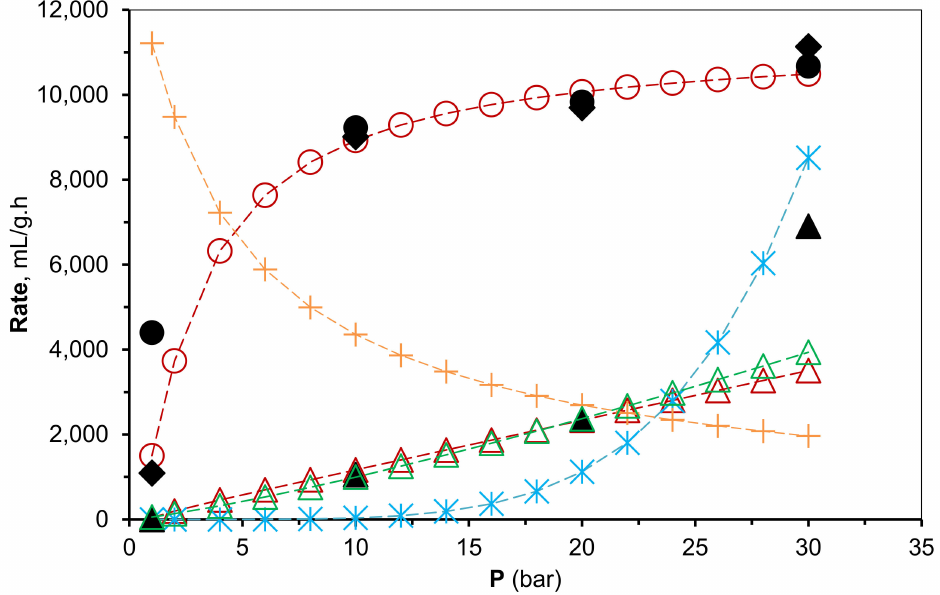
Figure 12. Correlation between experimental reaction rates obtained at 300 ◦ C and 30 bar over nickel– and cobalt–cerium bimetallic oxides prepared by the Pechini method (filled black circle and filled black triangle, respectively) and simulated data ( Langmuir–Hinshelwood–Hougen–Watson model power law: red circle, Equation (3); Chiang and Hopper power laws: red triangle, Equation (4) and orange cross, Equation (5); linear power laws, blue asterisk, Equation (2) x = 4, y = 1 and green triangle, Equation (2), x = 0.25, y = 1). Filled black lozenges correspond to the experimental data obtained over the reference catalyst (5 wt.% Rh/Al 2 O 3